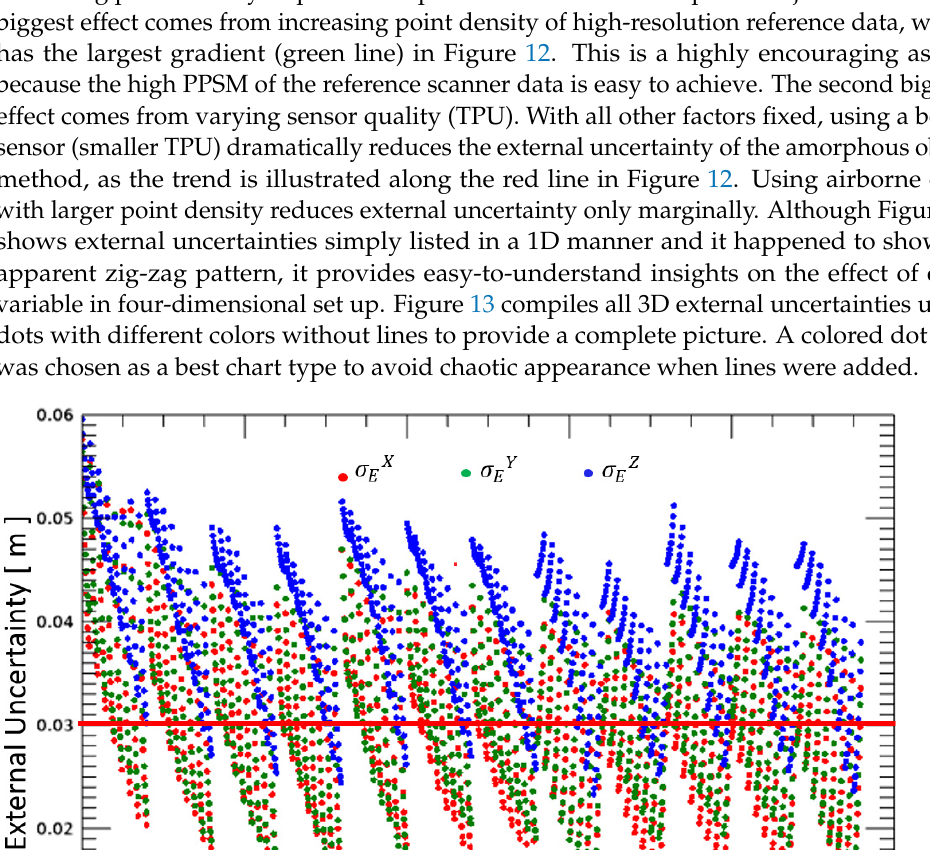
Figure 13. External uncertainty model for the amorphous object method.